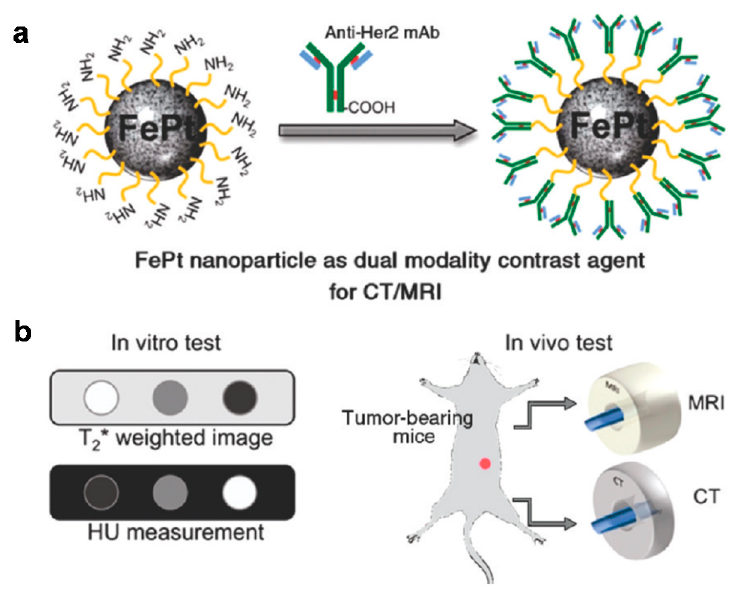
Figure 11. Schematic illustrations of ( a ) the surface functionalization of Anti-Her2 antibodies conjugated onto cysteamine capped FePt particles, and ( b ) in vitro and in vivo MRI and CT imaging using FePt nanoparticles as dual contrast agents. Reproduced with permission from reference [106].